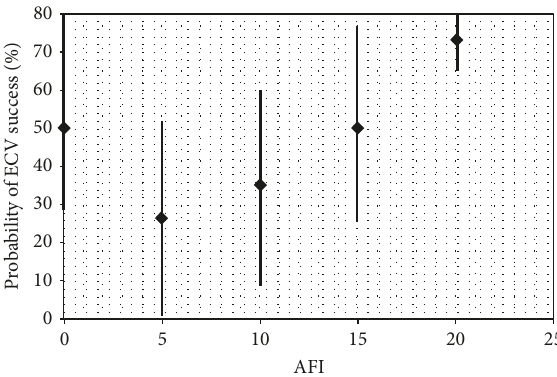
Figure 1: AFI versus probability of ECV